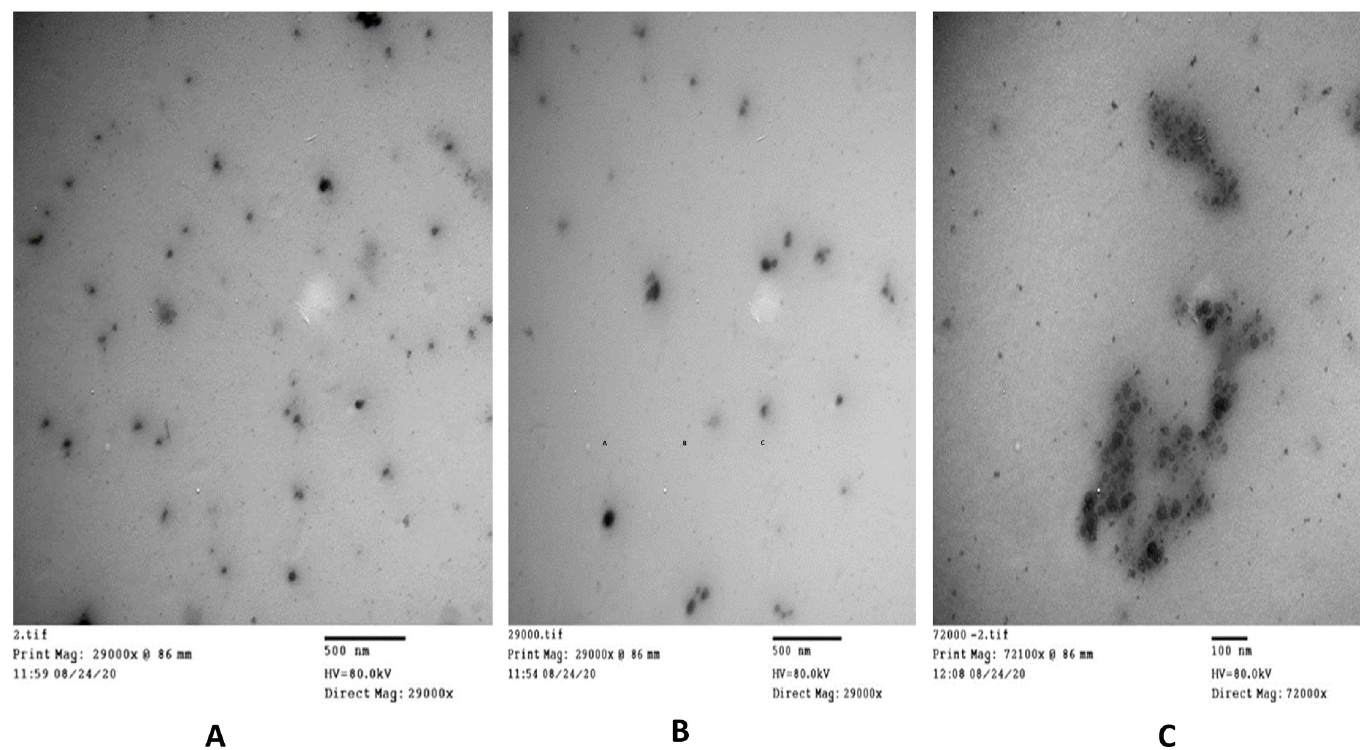
Fig 2. TEM analysis of the formulated